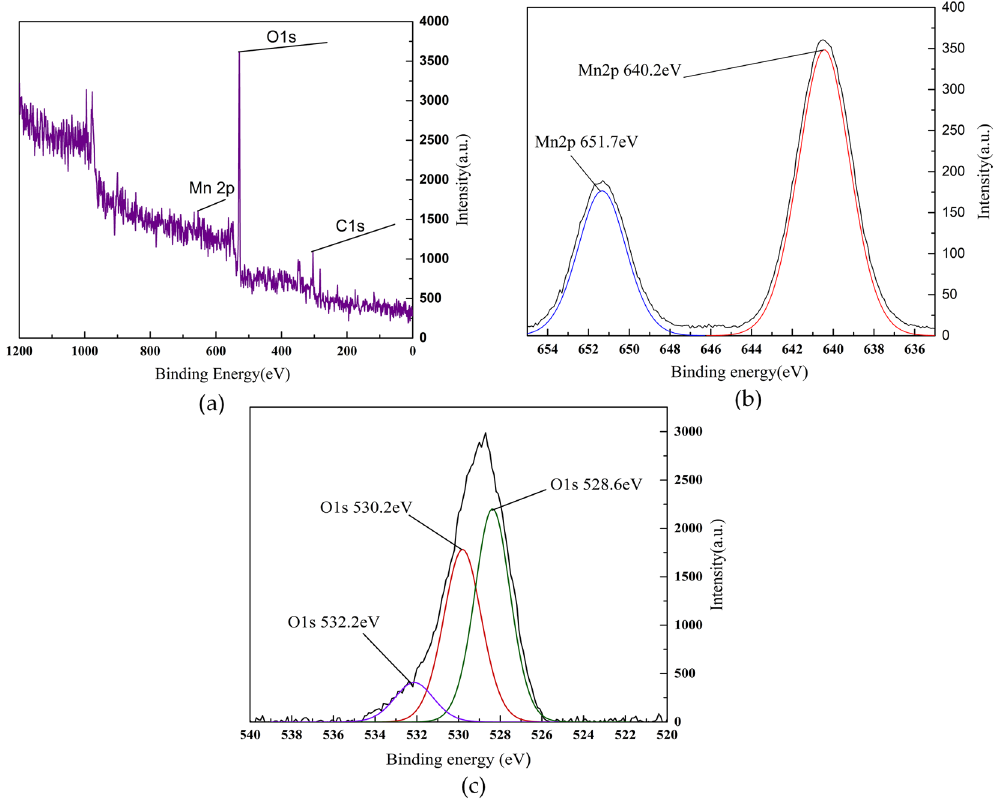
Figure 10. XPS spectrogram of MnOx-based sludge (involved in the denitration reaction). ( a ) Full scan spectra of MnOx; ( b ) Mn 2 P spectra of MnOx; ( c ) O 1 s spectra of